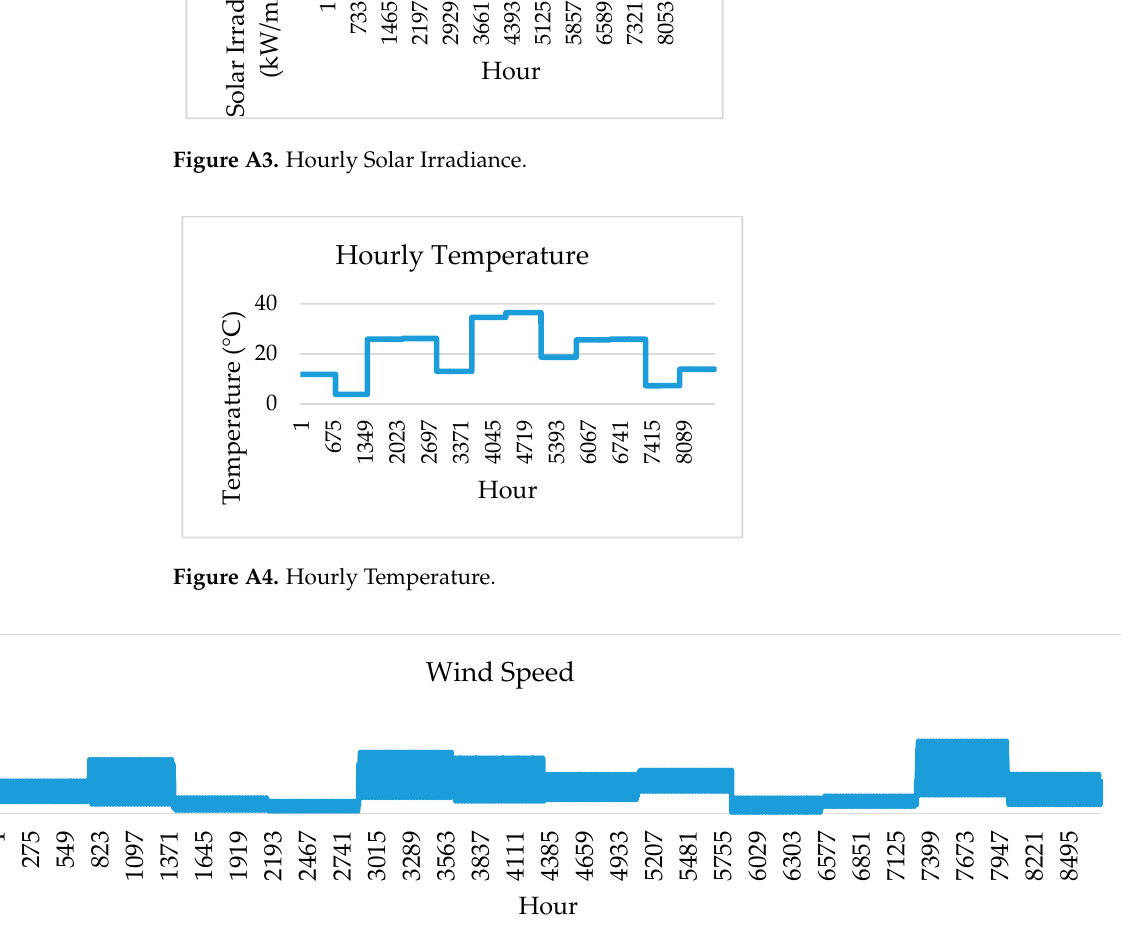
Figure A5. Hourly Wind Speed. Table A2. PWR of Different Components of Energy Systems